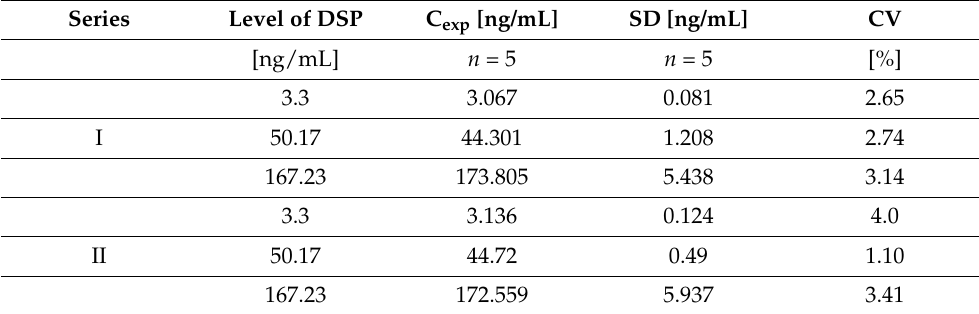
Table 1. Intermediate precision of vincristine analysis in various fortified serum samples at three levels of analyte